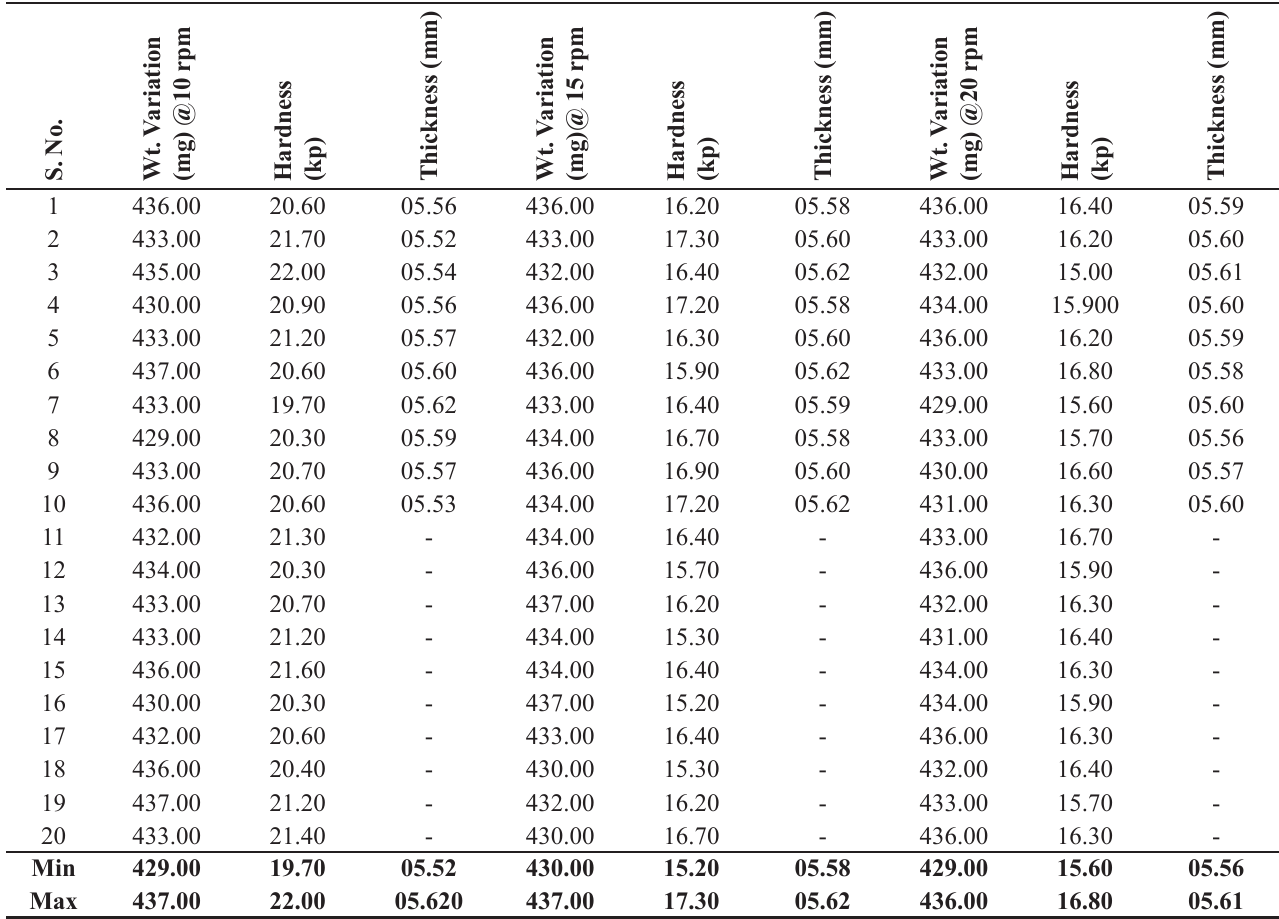
TABLE IV - Compression data form trial no T1A (using gravity feeder) of 24C screen milled granules